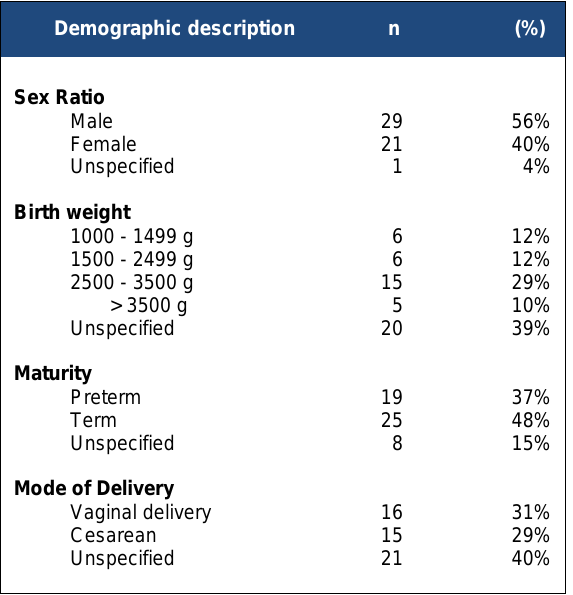
Table 1: Demographic pattern of neonatal ap- pendicitis